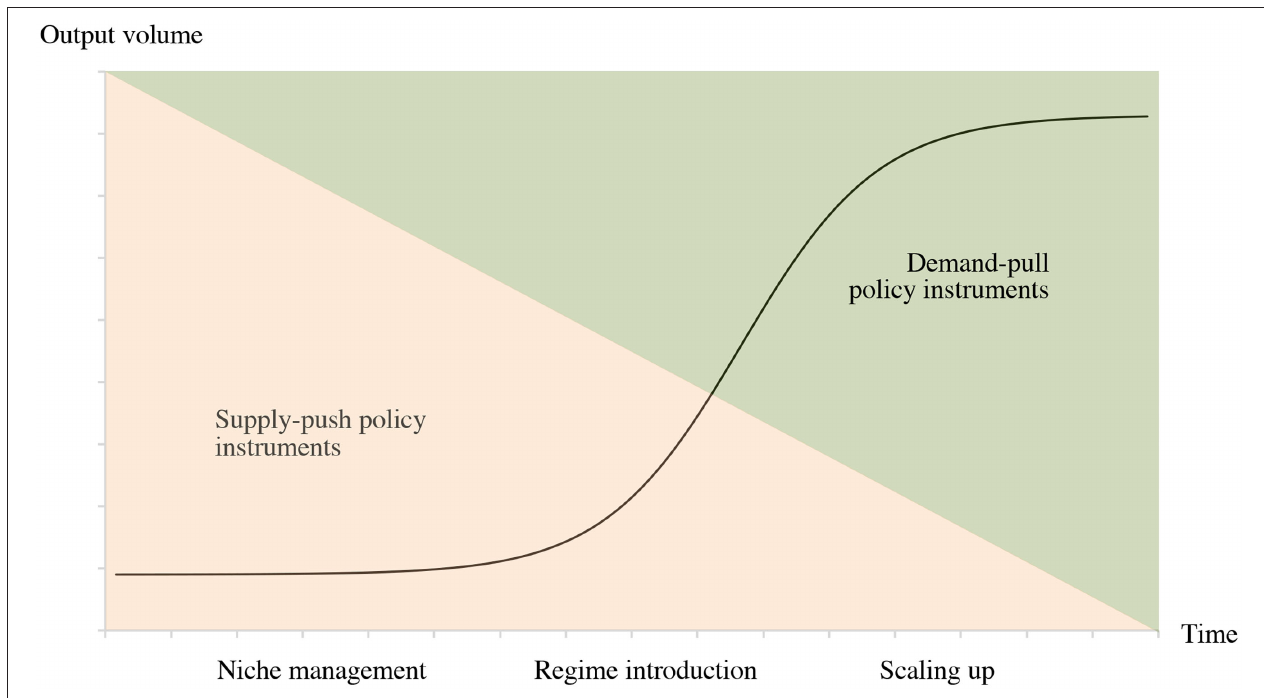
FIGURE 2 | Schematic S-curve for technology development and deployment in existing sociotechnical regimes.